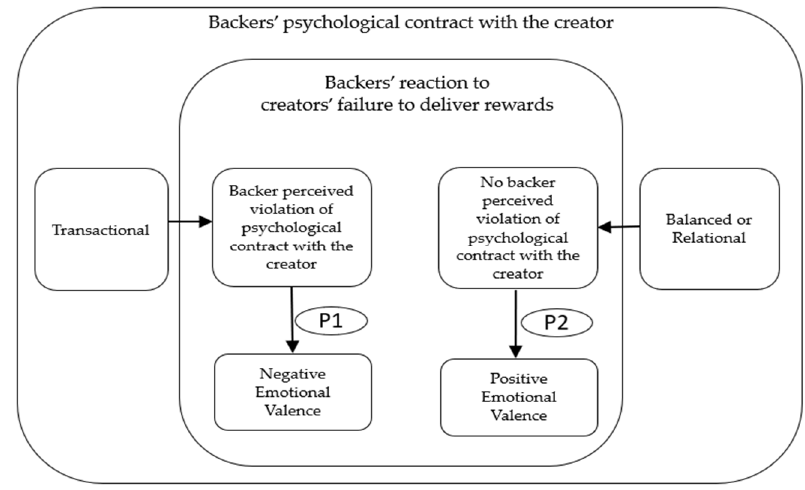
Figure 3. Research framework depicting the impact of creators’ failure to deliver rewards on backers’ emotional valence in rewards-based crowdfunding.